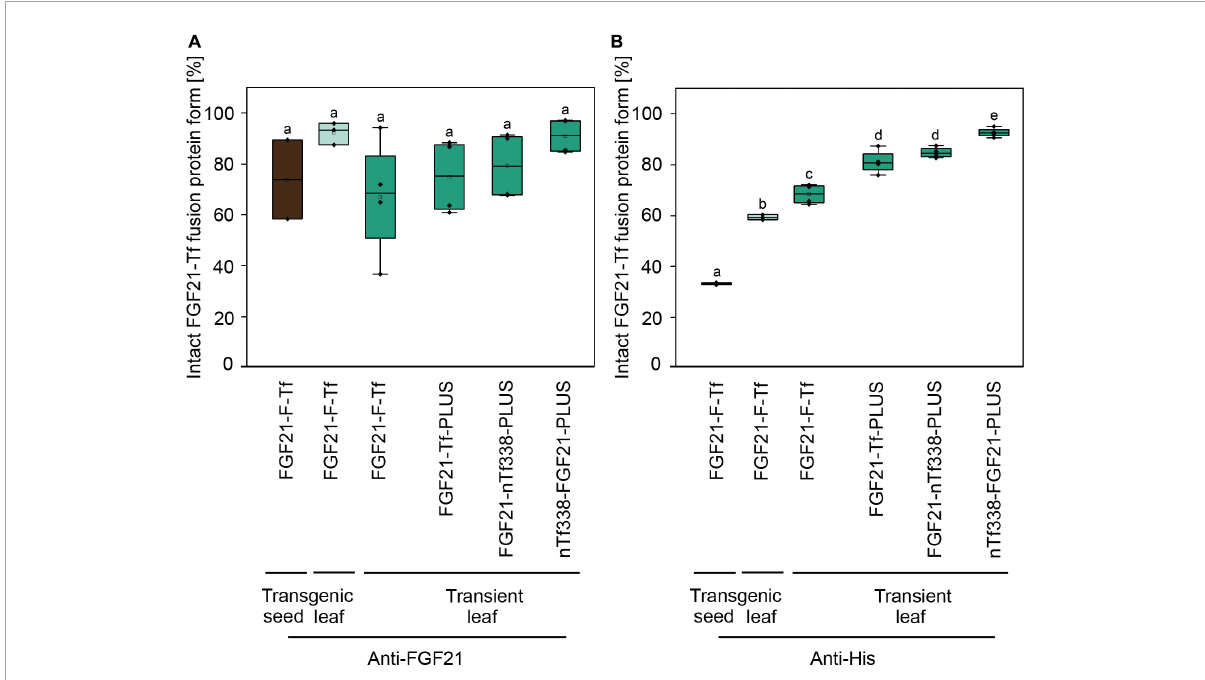
FIGURE2 Degree of degradation during extraction of optimized FGF21-transferrin fusion proteins in N. tabacum SL632 (SL1-1) and in N. benthamiana . Relative fraction of the intact FGF21-Tf fusion proteins in plant extracts, detected by (A) anti-FGF21 and (B) anti-His Western blots and